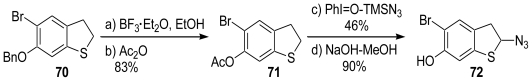
The synthesis of 2-azido-5-bromo-6-hydroxydihydrobenzothiophene (72).